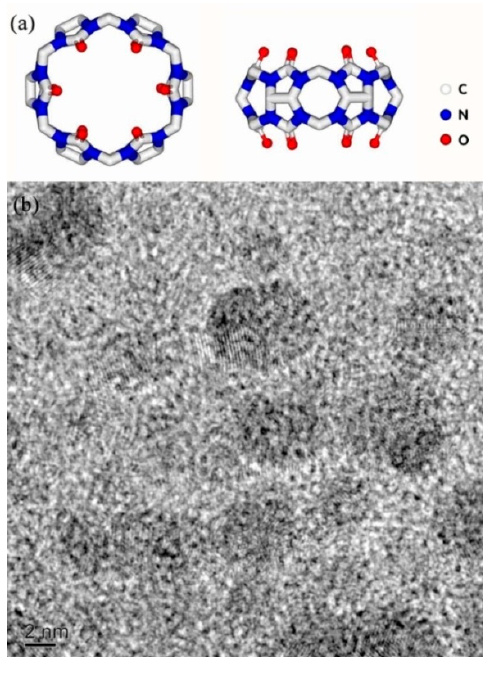
Figure 6. ( a ) Molecular structure and ( b ) TEM image of Q[6].